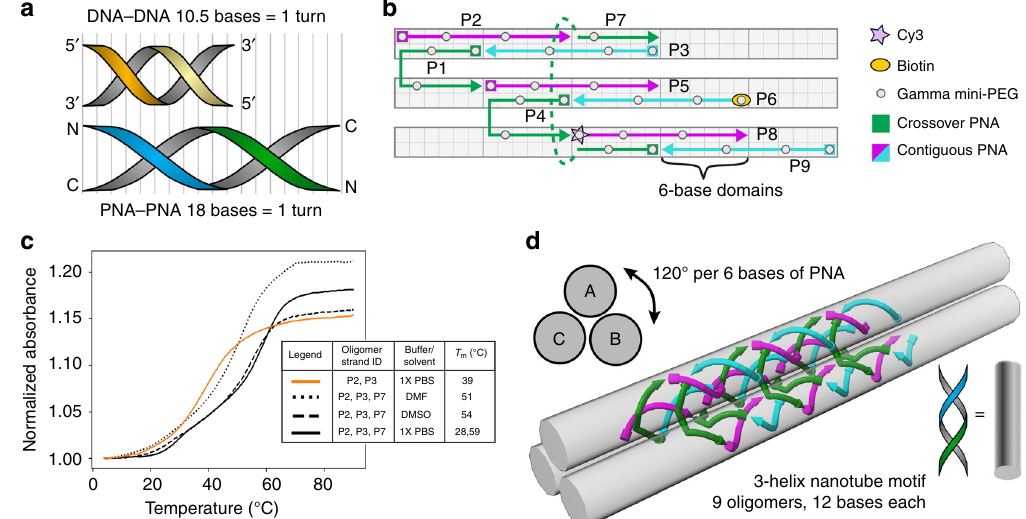
Fig. 1 The design of 3-helical γ PNA nano fi bers. a Schematic comparison between a full helical turn of DNA and PNA double helix. B-form DNA is typically stable with 10.5 bases per helical turn while PNA has a helical pitch of 18 bases per turn. b A schematic representation of the structural motif for the SST design that shows 6-base domains and an overall repeat unit of 18 bases. Each PNA oligomer is modi fi ed at the 1, 4, and 8 γ -positions with (R)-diethylene glycol (gray dots) to enable pre-organized helical conformation. γ PNA oligomers are classi fi ed into contiguous (magenta and cyan arrows) or crossover (green arrows) PNAs based on their position in the motif. Speci fi c γ PNA oligomers (P8 and P6) are labeled with fl uorescent Cy3 (pink star) and biotin (orange oval), respectively, to enable detection of structure formation using fl uorescence microscopy. c Melt curve studies show the melting temperatures of 2-oligomer (orange) and 3-oligomer (black) substructures in different solvent conditions vary between 39 and 59 °C. This indicates that 6-base domains are suf fi ciently stable for γ PNA – γ PNA systems in PBS (solid curve), DMSO (dashed curves), and DMF (dotted curves). Source data are provided as a Source data fi le. d 6-Base domains correspond to 120° rise in helical rotation enabling the structural motif to program the assembly of 3-helix nano fi bers that can polymerize